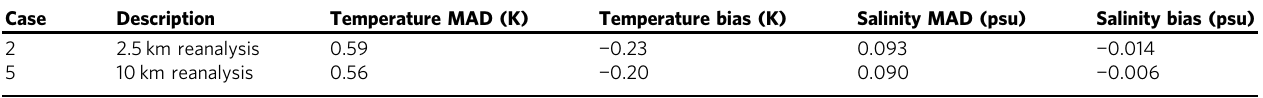
Table 2 Average sub-surface forecast innovation statistics for 2006 – 2008 in the Tasman Sea region Case